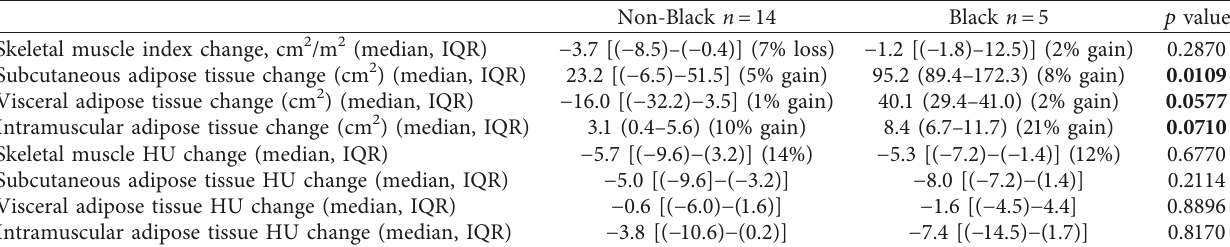
Table 3: Changes in body composition for Black versus non-Black men with hormone-sensitive metastatic prostate cancer and repeat computed tomography imaging a .